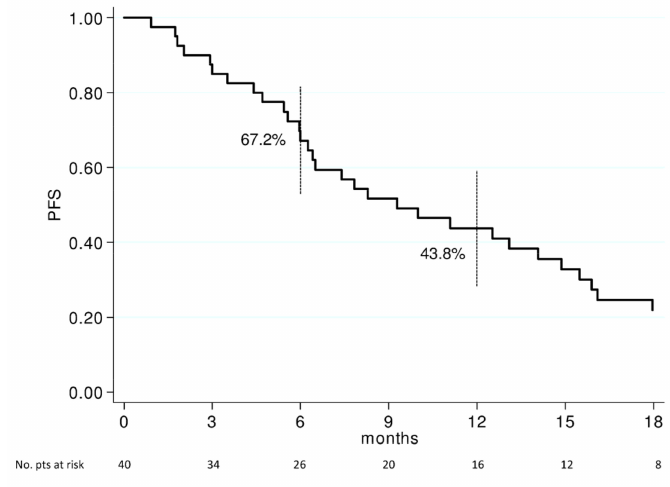
Figure 2. Progression-free survival of 40 patients with non-resectable LAPC. Vertical bars represent 95% Confidence Interval of survival probability at 6 and 12 months. PFS: Progression-Free Survival; pts: